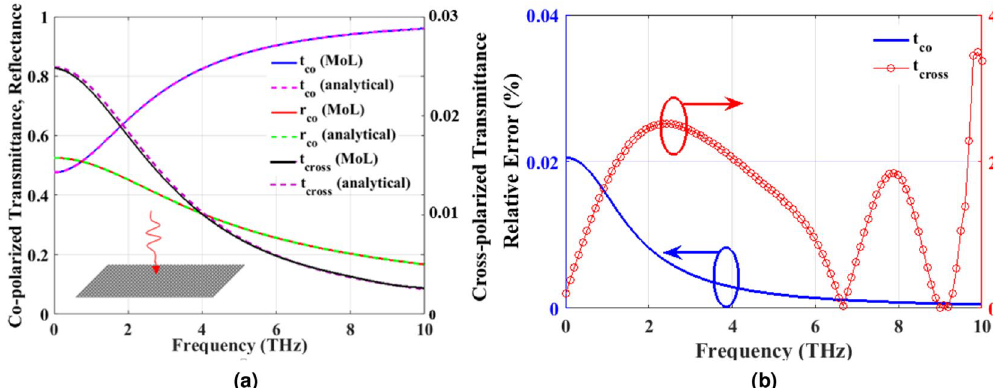
Figure 4. ( a ) Comparison of reflection and transmission coefficients of a free standing infinite graphene sheet obtained using both MoL (solid curves) and analytical formulation (dashed lines) for µ c = 0.5 eV, B 0 = 0.5 T, τ = 0.1 ps and T = 300 K, ( b ) Relative error between the MoL results and analytical formulations in the calculation of Co- and Cross-polarized transmission